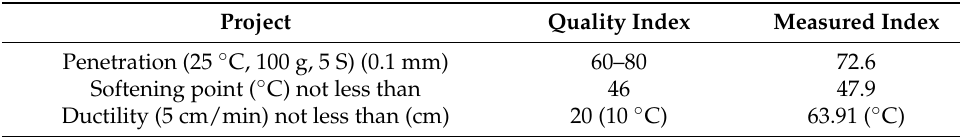
Table 1. 70#Asphalt performance index